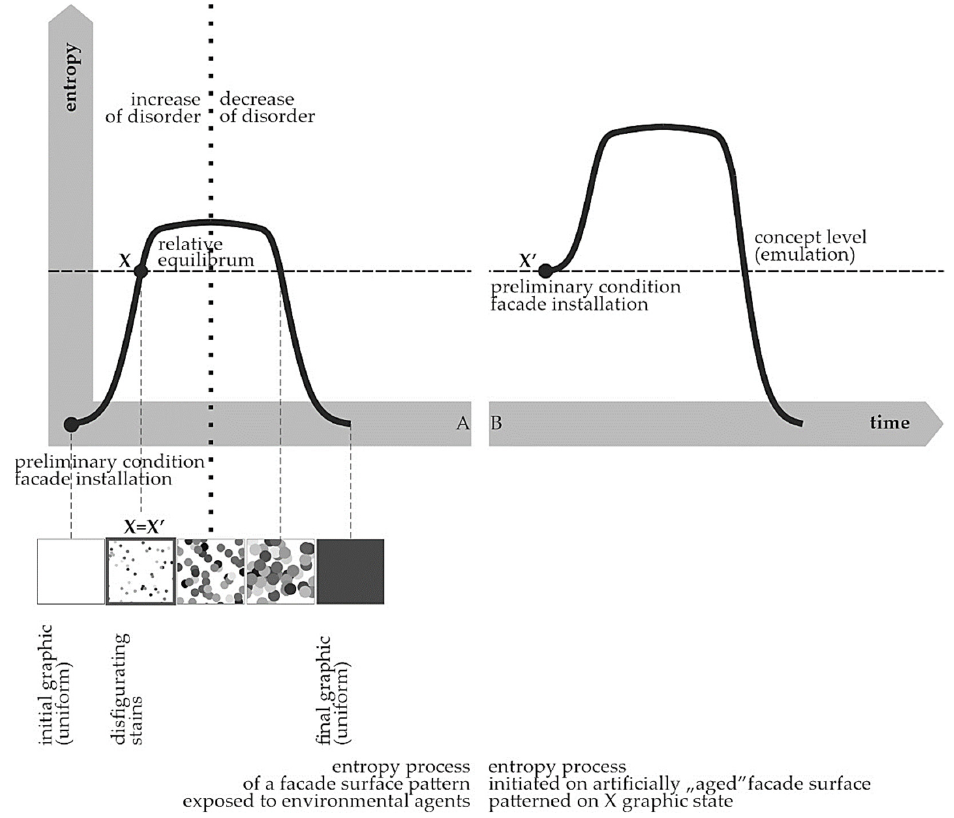
Figure 1. The mechanism of building skin graphic entropy plotted as a function of time ( A ) and its emulation in the ADAD concept ( B ) is considered from an art